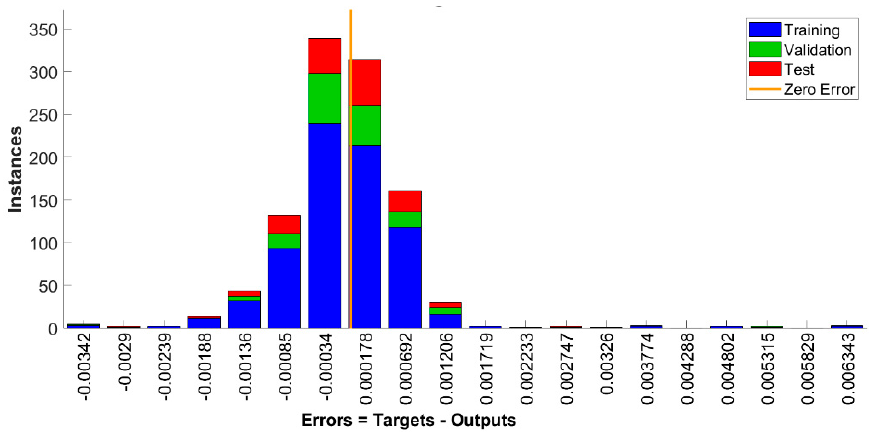
Figure 14. Error histogram with 20 bins for the training, test, and validations. Error ranges between − 0.0034 to +0.0063. Most samples were predicted with a tiny error next to zero. There are only a few samples’ data with an absolute error of about 0.0063.